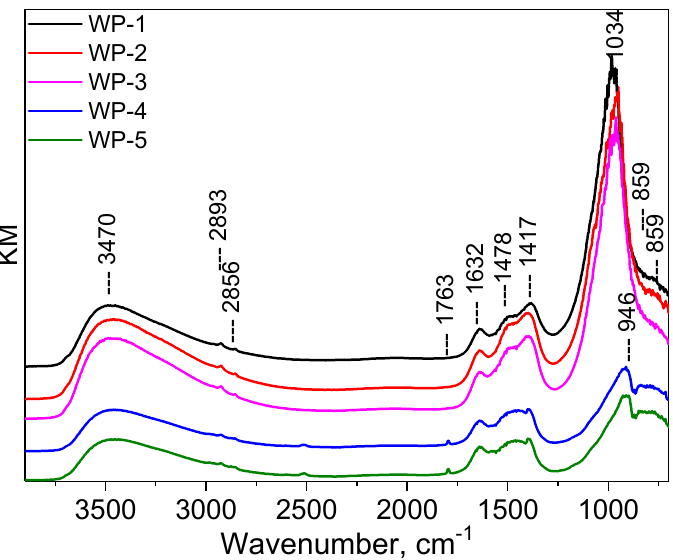
Figure 3. DRIFT spectra of the calcined WP